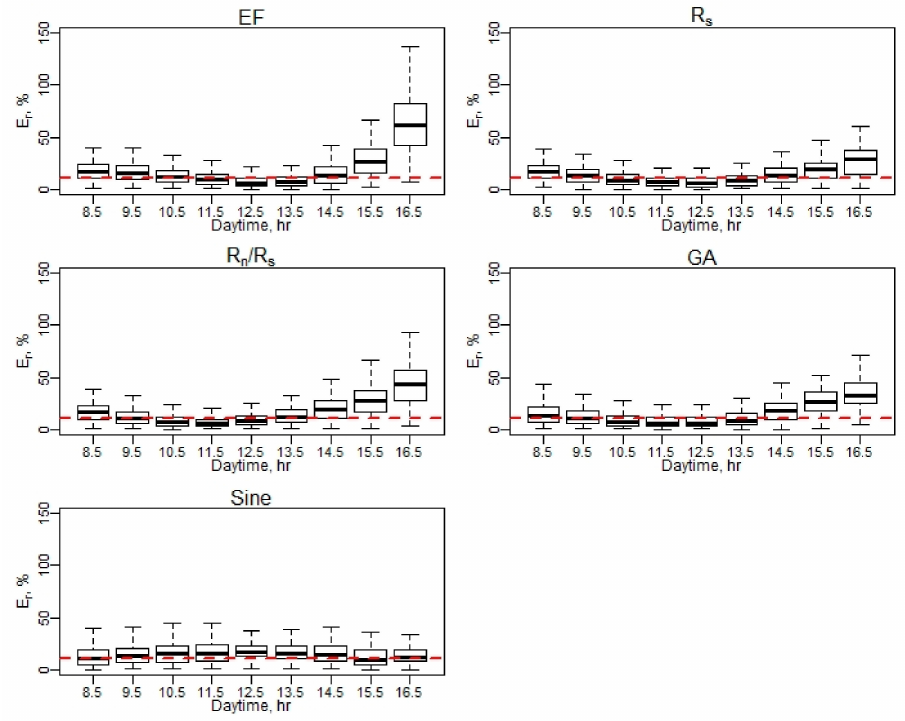
Figure A8. E r of daily EC ET